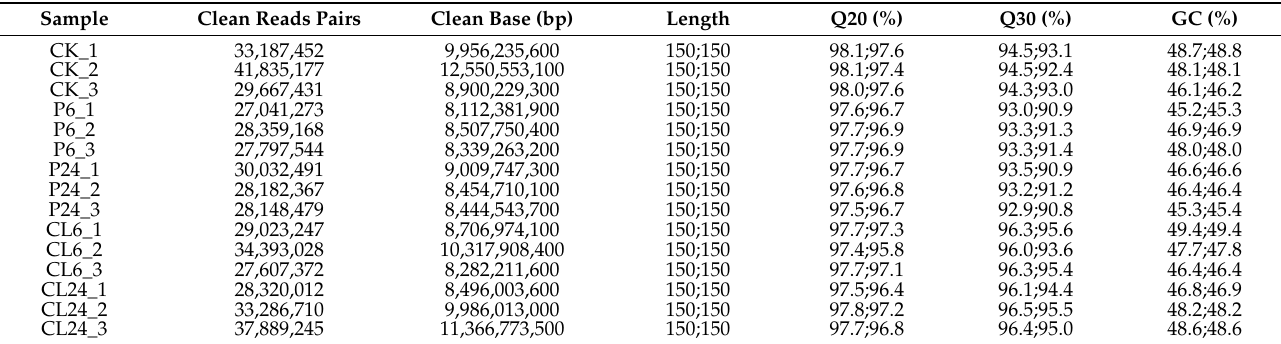
Table 1. Summary of the H. hamabo sequences analysed.